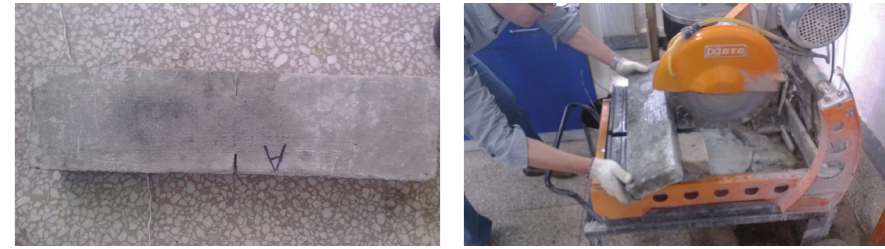
Figure 3: Damage simulation of slab using cutting